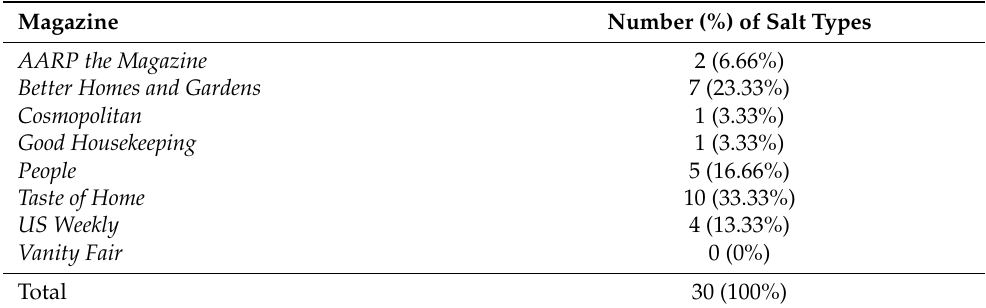
Table 4. Number of salt types listed in the ingredient list reviewed in recipes that listed salt by magazine published between 2019 and